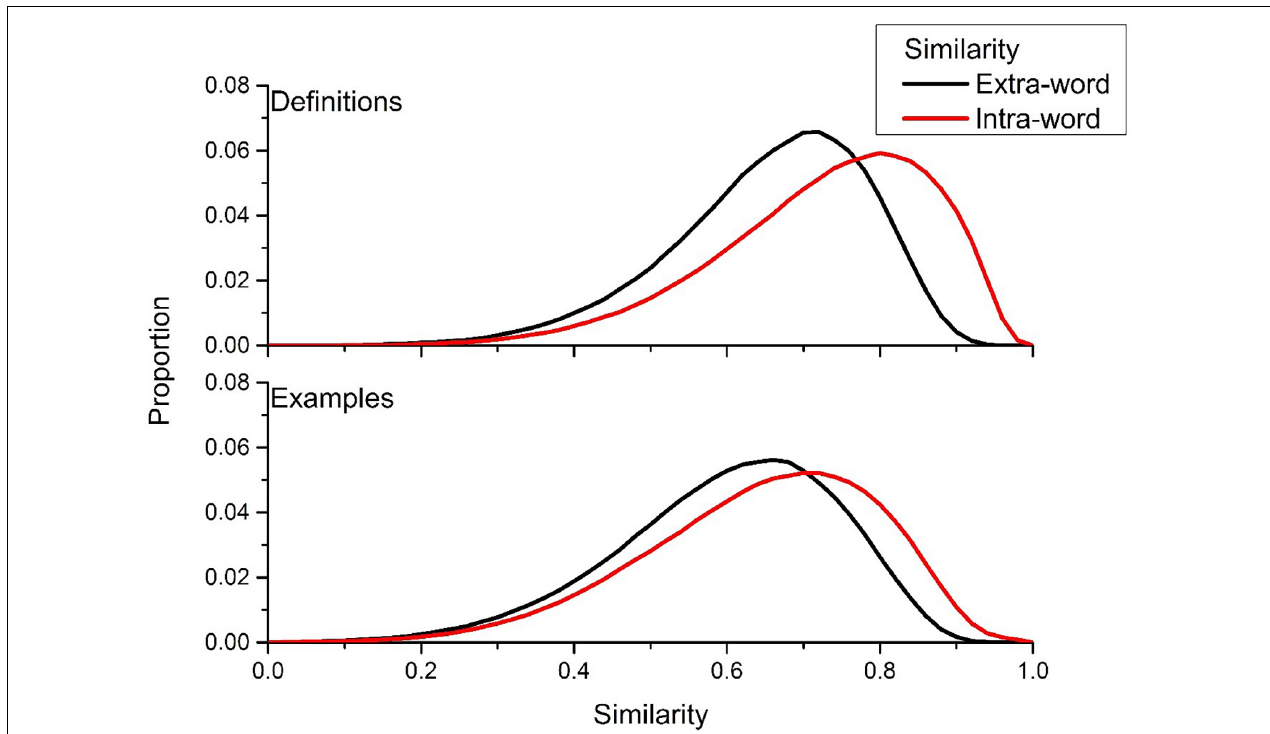
FIGURE 2 | Intra- and extra-word similarity distributions for UD definitions (top) and example usages (bottom) . The positive shift of the intra-word similarity distribution in comparison to the extra-word similarity distribution signals that there is internal consistency in the meaning of the definitions and example usages that UD users are